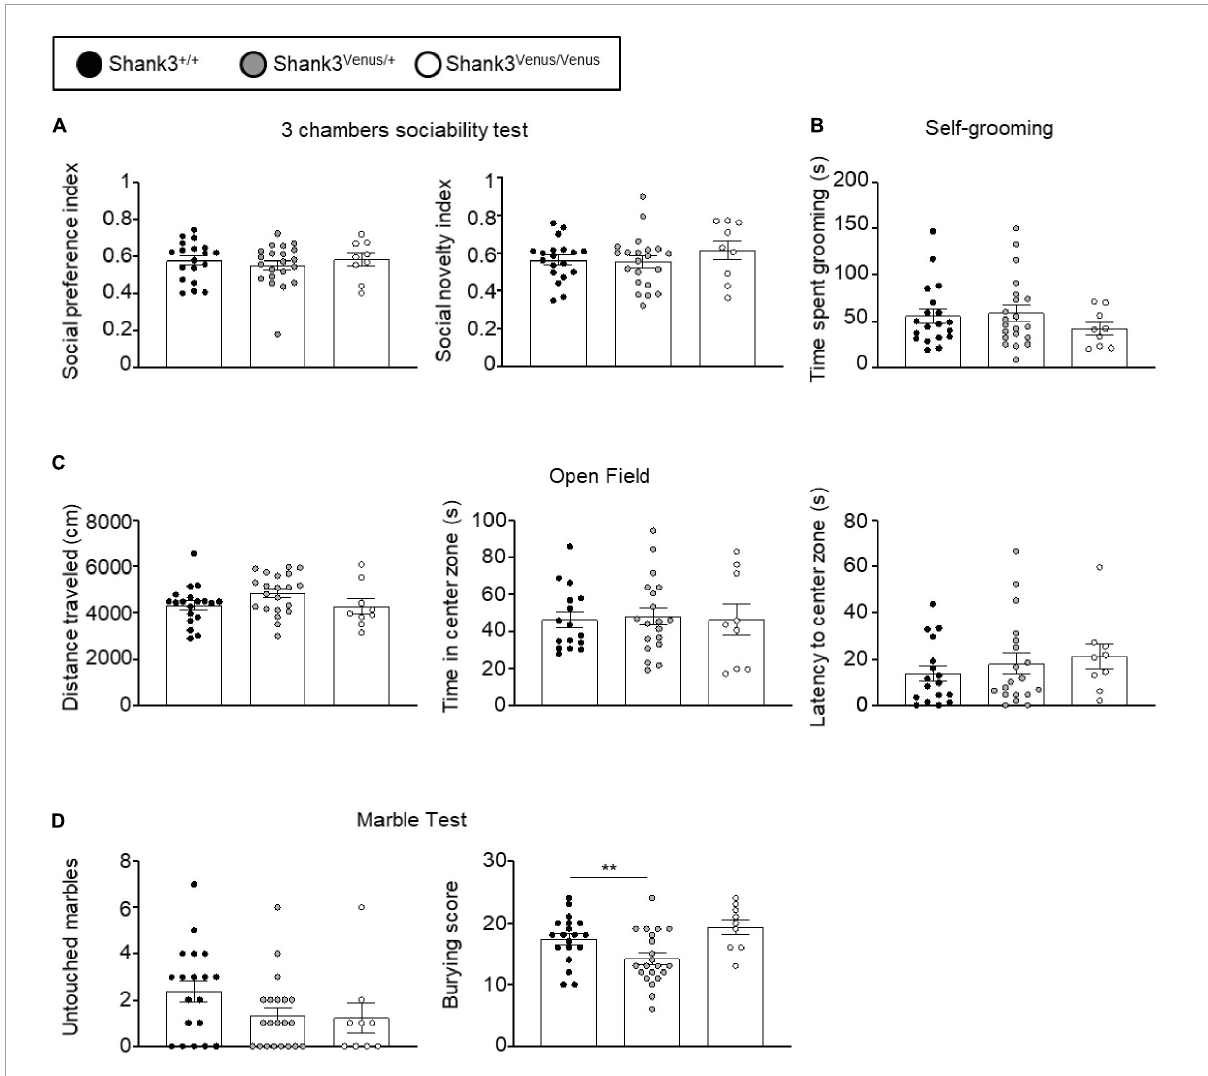
FIGURE3 Behavioral test battery in Shank3 Venus / Venus , Shank3 Venus / + , and Shank3 + / + KI adult mice. (A) Three chambers sociability test. Social preference index: time spent in social stimulus side chamber divided by time spent in both chambers. Social novelty index: time spent in the novel social stimulus side chamber divided by time spent in both chambers. One-way ANOVA, p -values = 0.71 and 0.51 for social preference and social novelty indexes respectively. (B) Self-grooming. Time spent by the mice grooming during a 10 min period. Kruskal–Wallis test, p -value = 0.48. (C) Open Field. Total distance traveled by the mice during the 10 min test. One-way ANOVA, p -values = 0.13. Time spent in the center zone. One-way ANOVA, p -values = 0.95; latency to the first entry into the center zone. Kruskal–Wallis, p -value = 0.38. (D) Marble burying. Number of marbles untouched. Kruskal–Wallis, p -value = 0.11. Score of marble burying. One-Way ANOVA, p -value = 0.004. Bars are mean ± SEM. from 19 Shank3 + / + , 21 Shank3 Venus / + , and 9 Shank3 Venus / Venus except for Open field’s time spent in the center zone and latency to the center zone where data are from 17 Shank3 + / + , 19 Shank3 Venus / + , and 9 Shank3 Venus / Venus